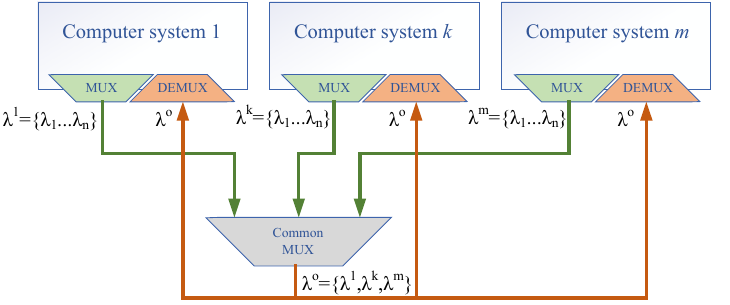
Figure 4. The architecture of the OBAON-based